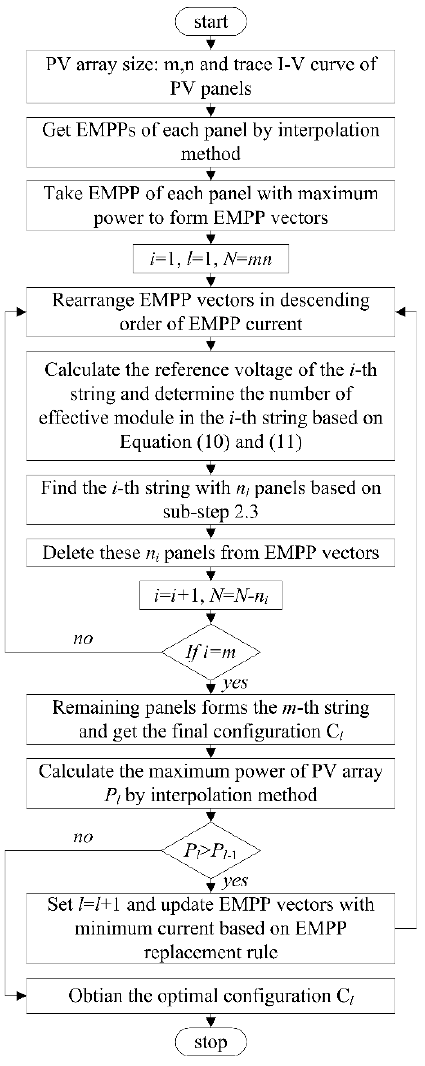
Figure 6. Flowchart of the proposed reconfiguration algorithm.